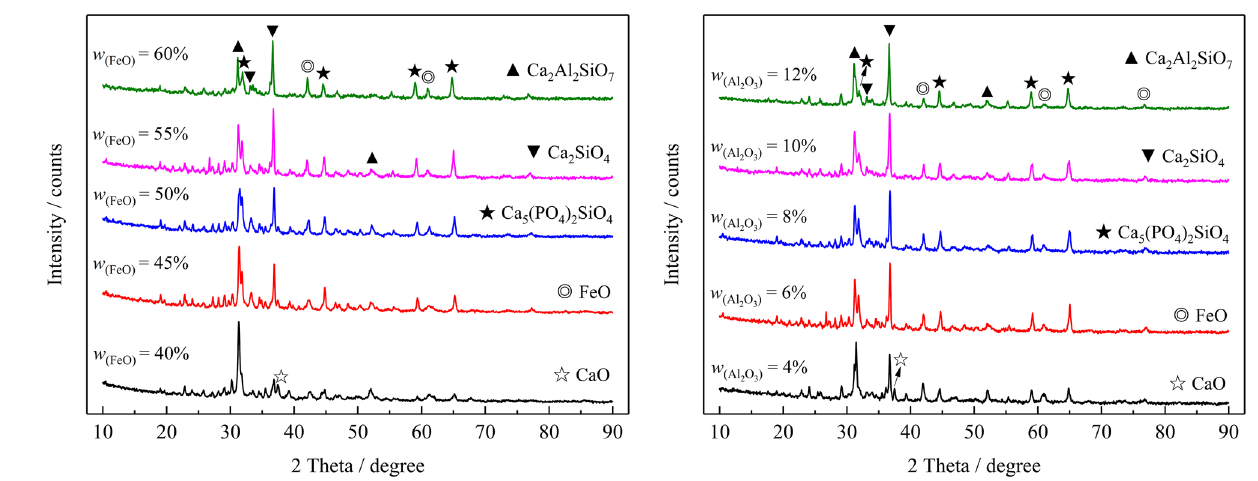
Figure 6: XRD patterns of the high - P - containing slag at di ff erent FeO contents.